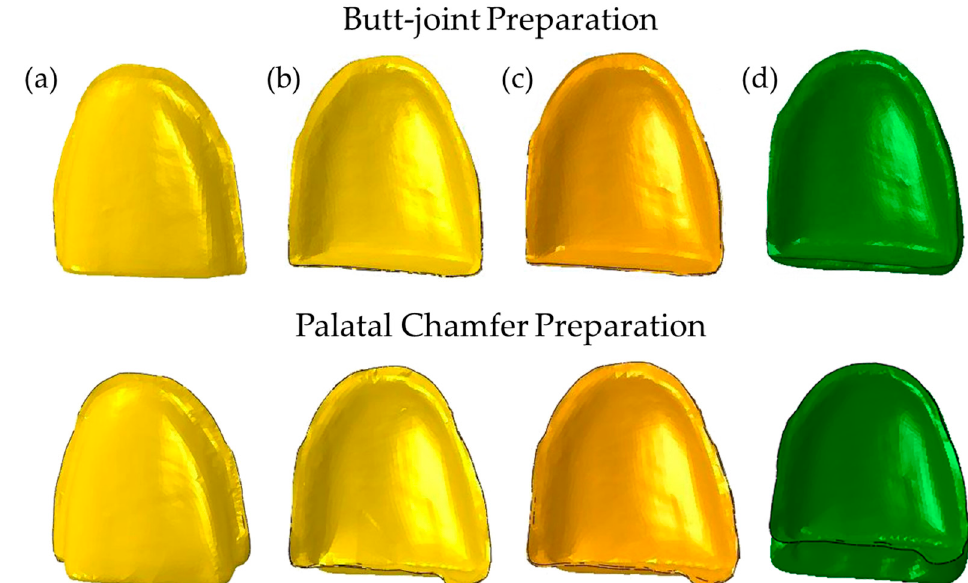
Figure 1. Butt joint and palatal chafer preparations: ( a ) adhesive layer in buccal aspect, ( b ) adhesive layer in palatal aspects, ( c ) resin cement in palatal aspects, and ( d ) laminate veneer in palatal aspects.